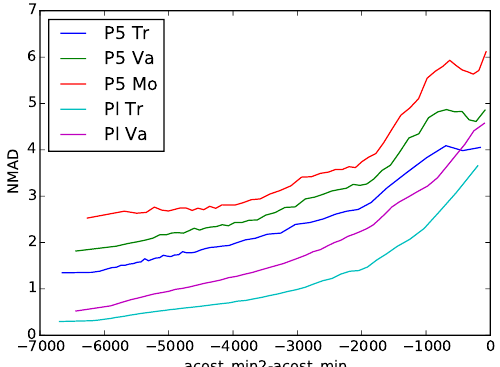
Figure 4: Dependence of height error on slope for Cartosat-1 (P5) and Pleiades (Pl) DSMs.